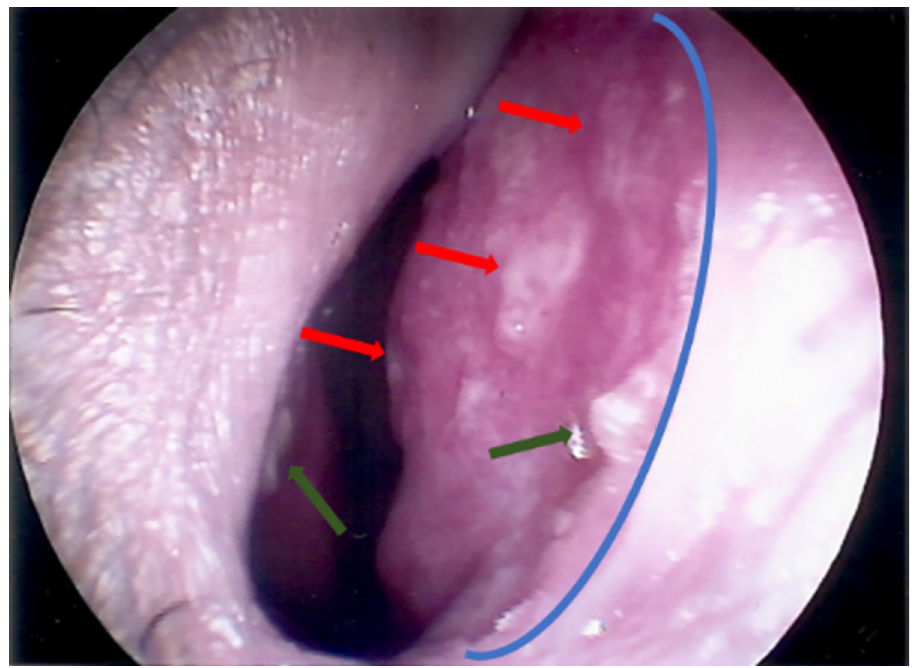
Fig 3. Mixed appearance of sporotrichosis in the nasal mucosa of a patient (case 24) treated at the ENT outpatient clinic at INI/FIOCRUZ. Nasal septum (right). Infiltration (blue). Granulation (red). Microabscesses (green). Source: Ana Cristina da Costa Martins (ENT outpatient clinic, INI/FIOCRUZ).